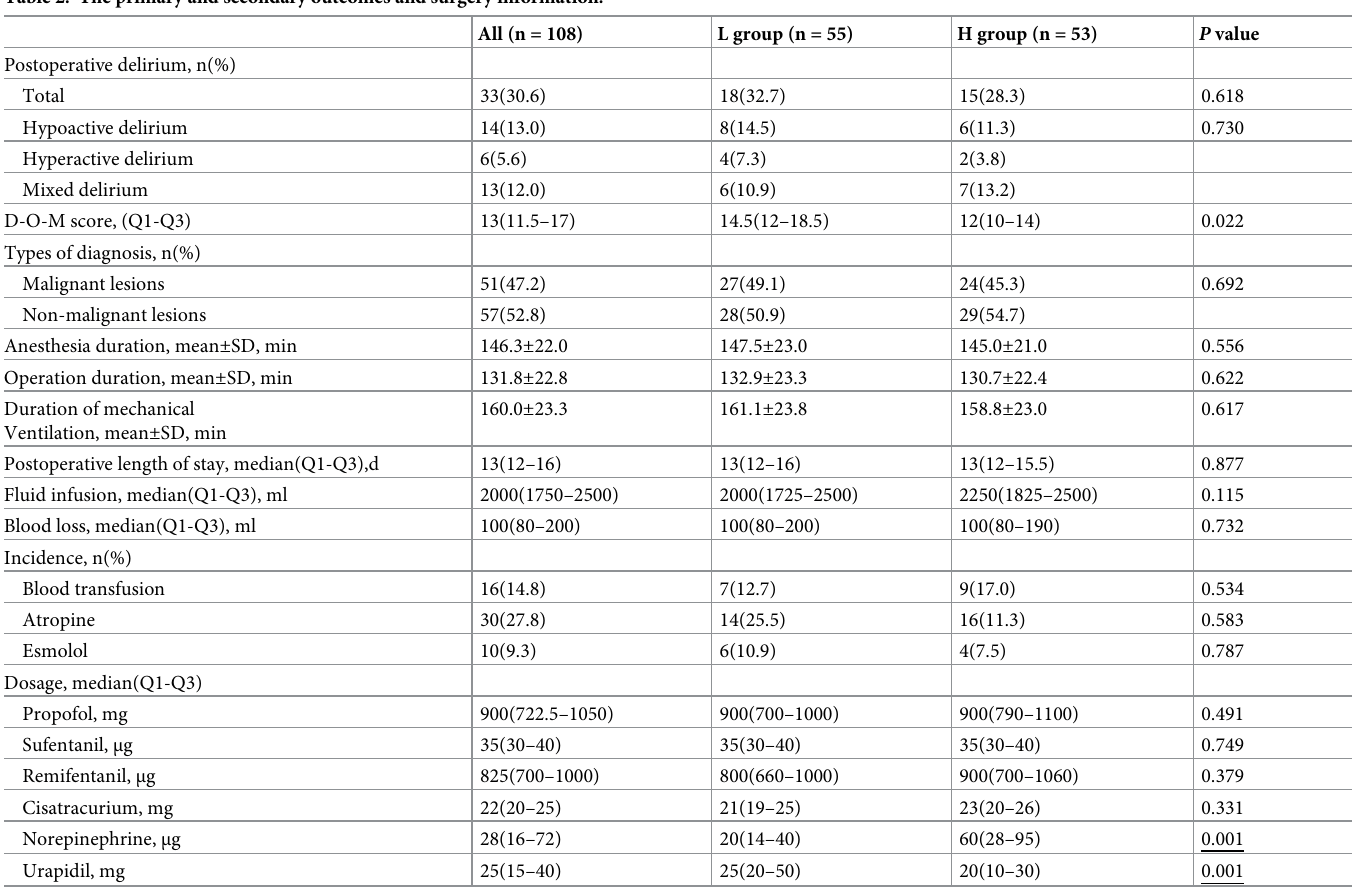
Table 2. The primary and secondary outcomes and surgery information.